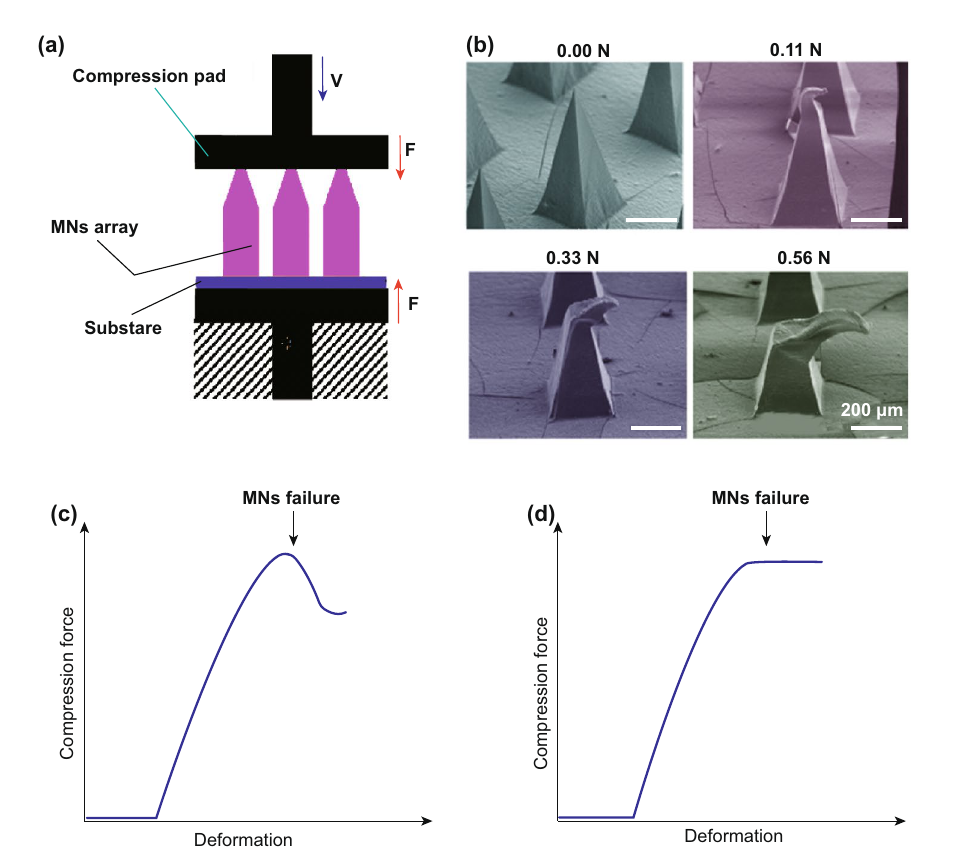
Fig. 4 a Schematic illustration of the compression test for a single microneedle (MN). b SEM images of MNs after applying different compres- sive forces. Reprinted from Ref. [84] with permission from MDPI. c MNs failure with suddenly dropped force. d MNs failure with saturated